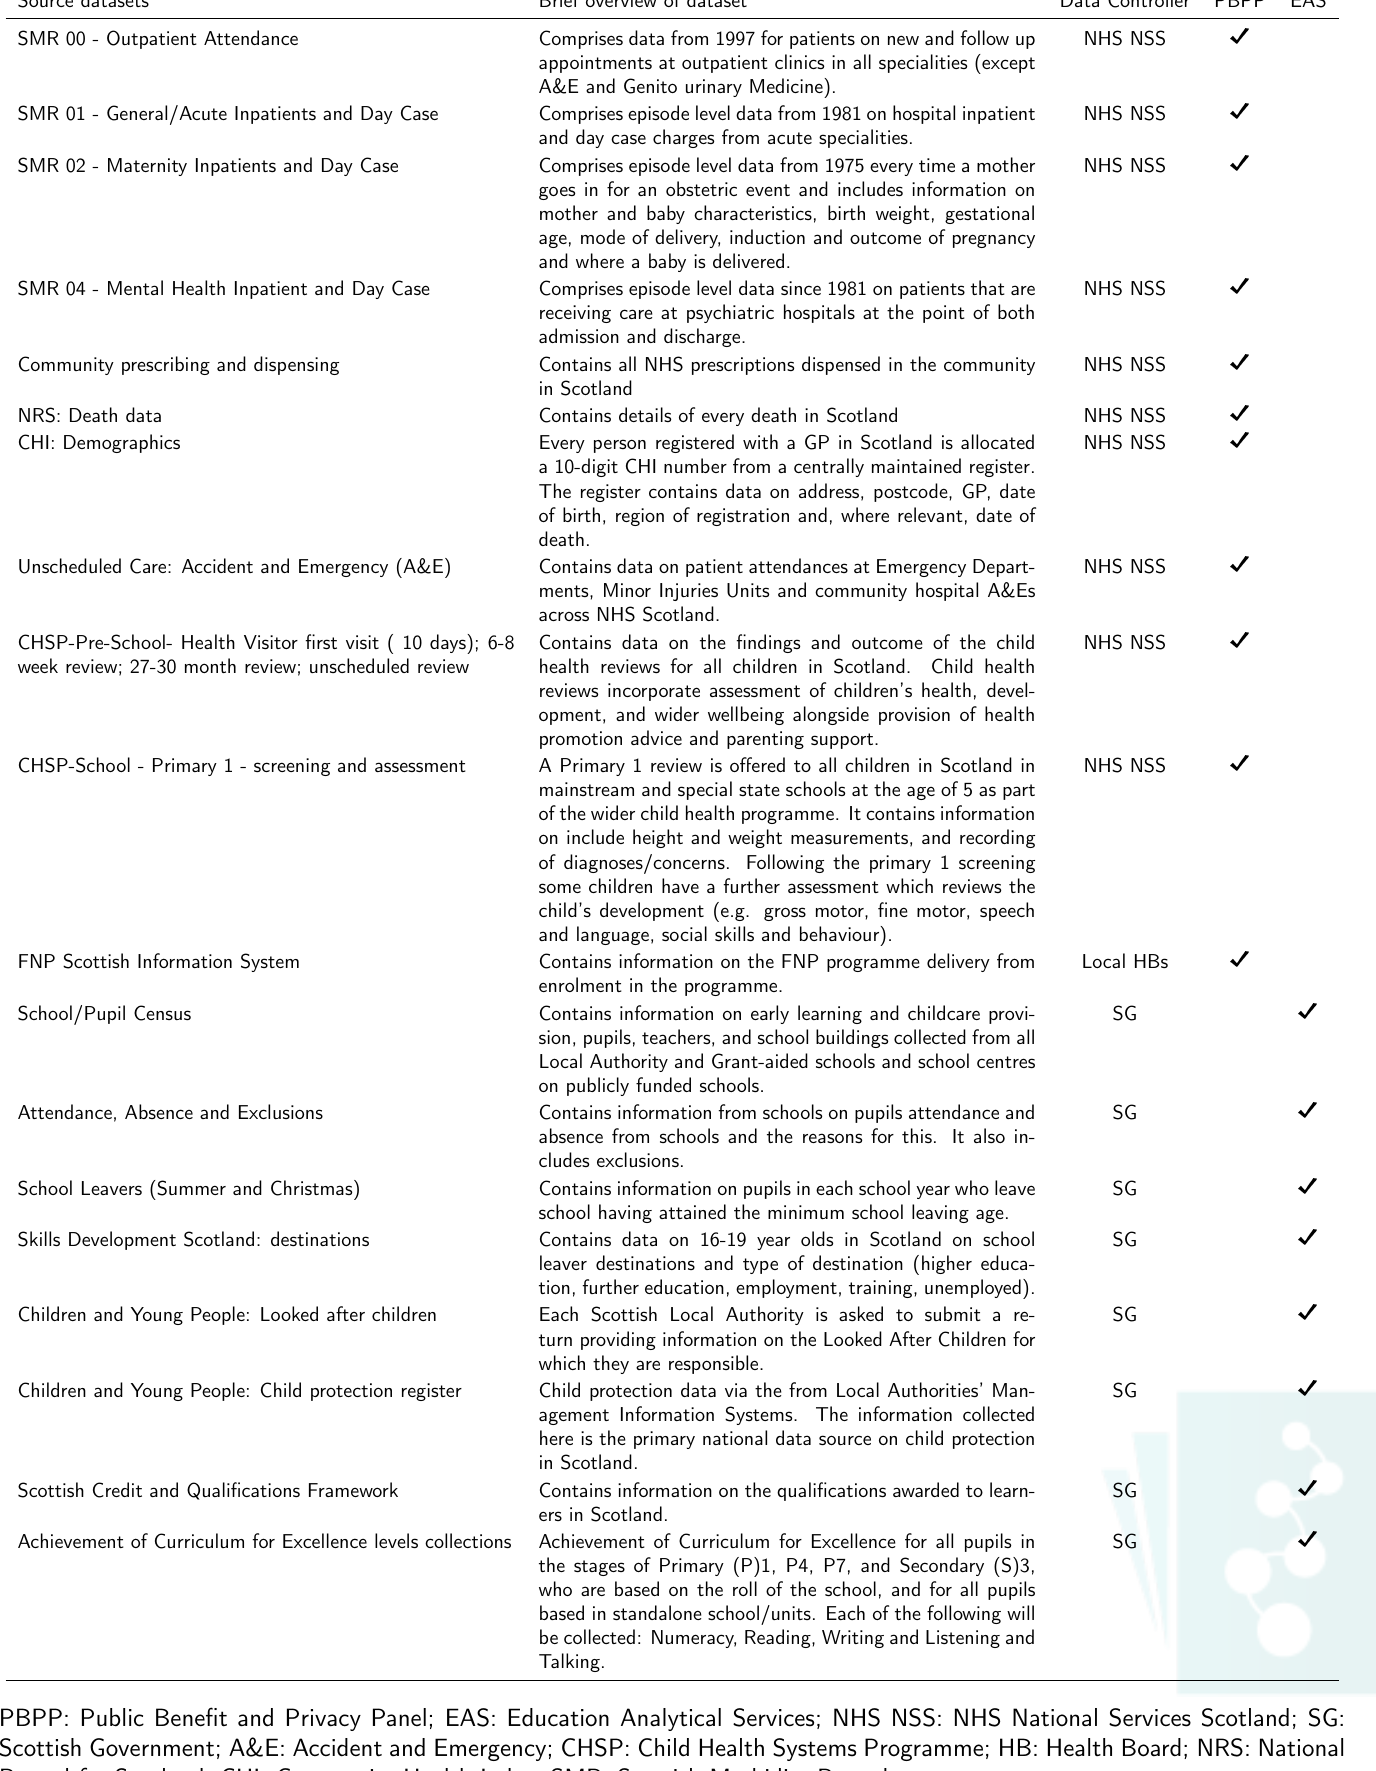
Table 2: Maternal baseline characteristics measured at (or before) date of antenatal booking/enrolment Source